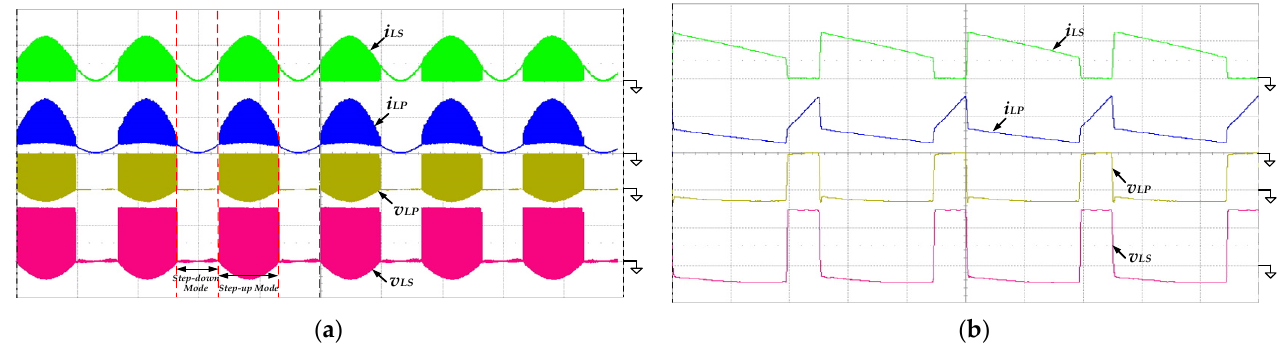
Figure 16. The measured waveforms of the inductor currents i LP , i LS and the inductor voltages v LP and v LS at 200 V input voltage, 500 W output load and ( a ) low-frequency line cycle ( v LP , v LS : 200 V/div; i LP : 10 A/div; i LS : 5 A/div; time: 5 ms/div); ( b ) high-frequency switching cycle ( v LP , v LS : 200 V/div; i LP : 10 A/div; i LS : 5 A/div; time: 20 μ s/div). The total harmonic distortion (T.H.D.) and odd-order harmonics of the output volt- age at full load are measured and listed in Table 4. All measured harmonics comply with the standard of EN6100-3-2 Class C. The efficiency curves of the proposed inverter are illustrated in Figure 17. As can be seen, the conversion efficiencies reach up to 96.1% at